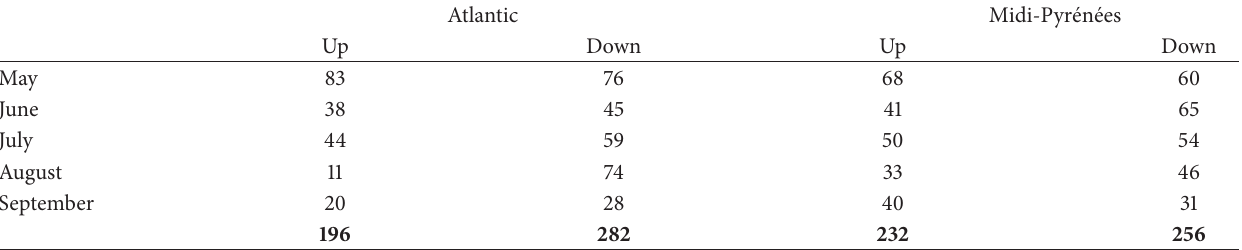
Table 5: Number of stations with positive and negative monthly trends from 1990 to 2010, in Atlantic and Midi-Pyr´en´ees areas.